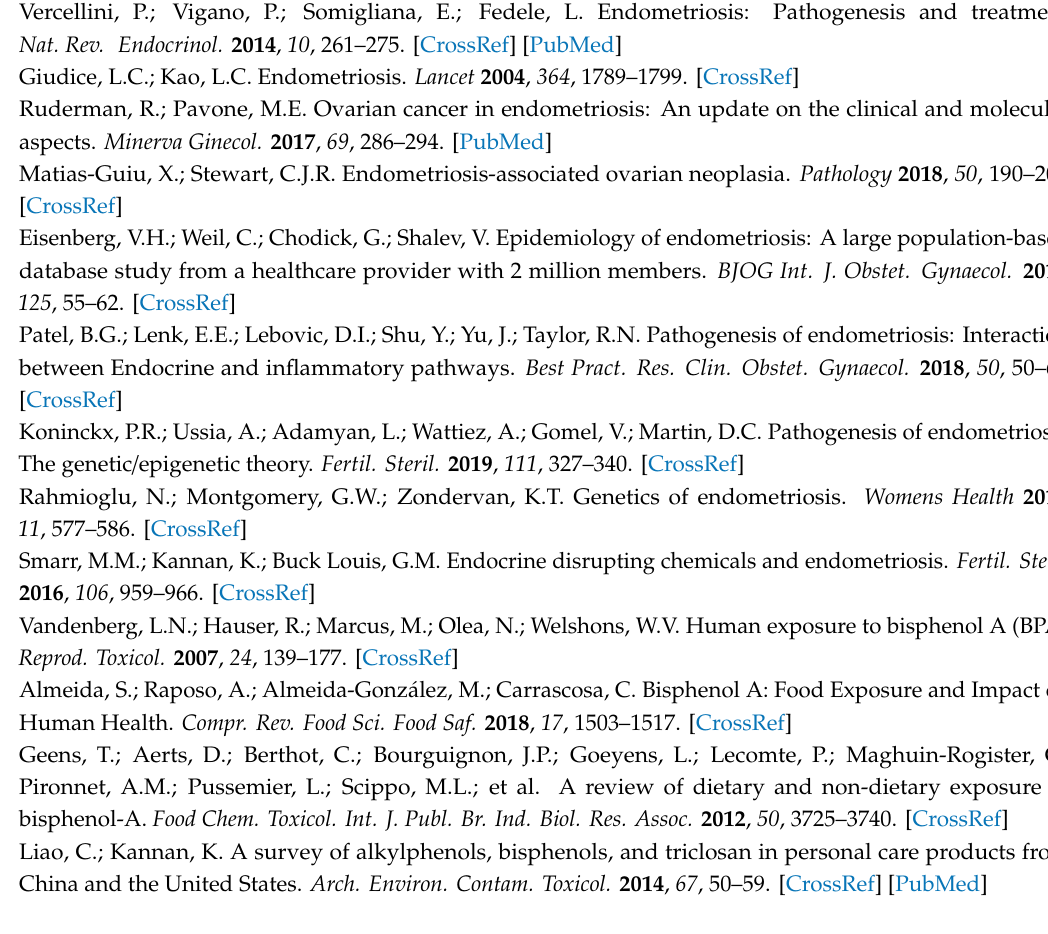
Table S1: Urinary levels of bisphenols in controls and cases stratified according to the endometriosis stage. Author Contributions: F.A.-C. and O.O.-H. conceived, designed, and implemented the study. N.O, M.F.F., R.S., J.F.-P., and B.P.-C. helped with the design and the implementation of the study and coordinated patient recruitment. F.M.P., L.M.I.-D., and F.V.-S. performed the chemical analyses, while J.L. carried out the oxidative stress quantification. C.F., O.O.-H., and F.A.-C. analyzed and interpreted the data, and F.M.P and I.L. drafted the paper. N.O., M.F.F., R.S., J.F.-P., and B.P.-C. contributed to the interpretation of the data and critically revised